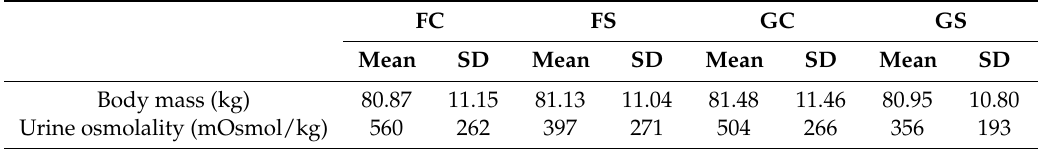
FC, fructose ingestion control trial; FS, fructose ingestion supplement trial; GC, glucose ingestion control trial; GS, glucose ingestion supplement trial; SD, standard